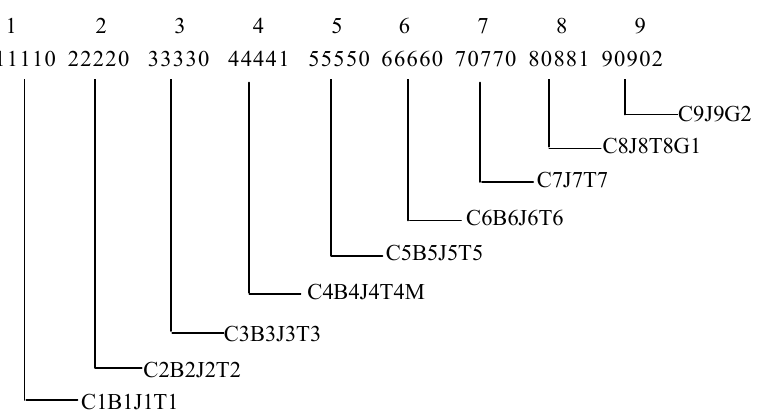
Figure 6. Coding of excavation procedure for cavern group.